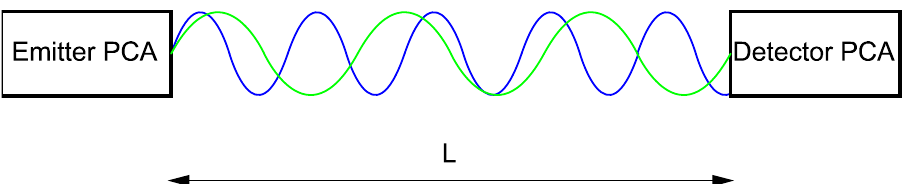
Figure 5. Phase change dependency on the variable frequency at fixed distance L between emitter PCA and detector PCA.